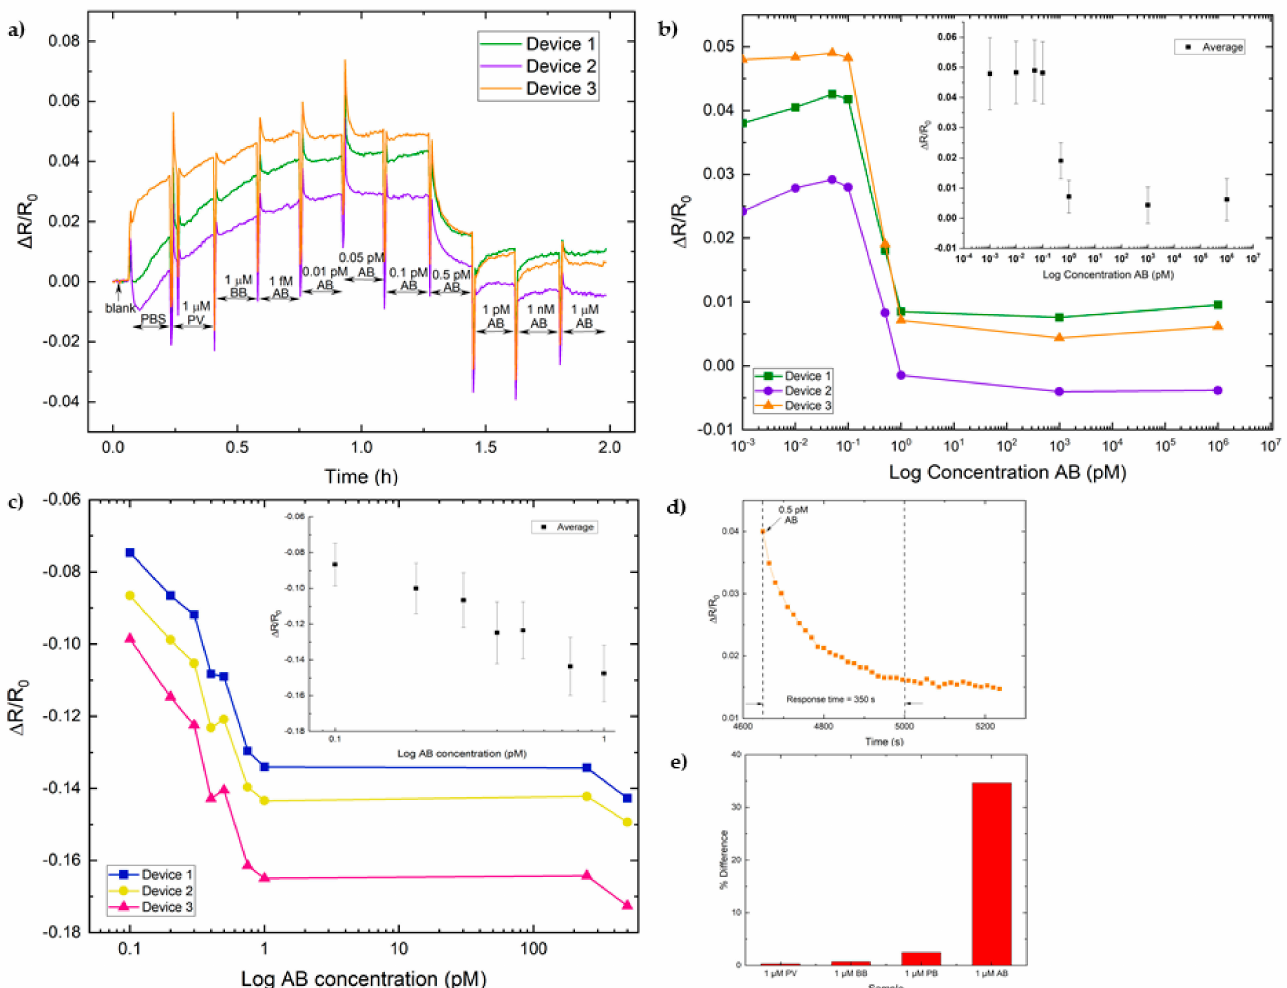
Figure 8. ( a ) Real-time resistance measurements of the OR2AG1 functionalized sensor, where ∆ R/R 0 = R device − R 0 /R 0 , and R 0 is the resistance at T = 0 (resistance of OR2AG1 functionalized graphene). A concentration range of 10 − 15 to 10 − 6 M in PBS was used for the target odorant, amyl butyrate (AB), and 10 − 6 M in PBS was used for pentyl valerate (PV) and butyl butyrate (BB) controls (all prepared using 1 M stock solutions in DMSO). ( b ) Picomolar amyl butyrate concentration (logarithmic scale) plotted against resistance with inset error bars. ( c ) Picomolar amyl butyrate concentration (logarithmic scale) repeat with additional concentrations (0.1, 0.2, 0.3, 0.4, 0.75, 250, 500 pM) plotted against resistance with inset error bars. ( d ) Real-time reaction time graph showing response time after adding the target odorant (amyl butyrate, 0.5